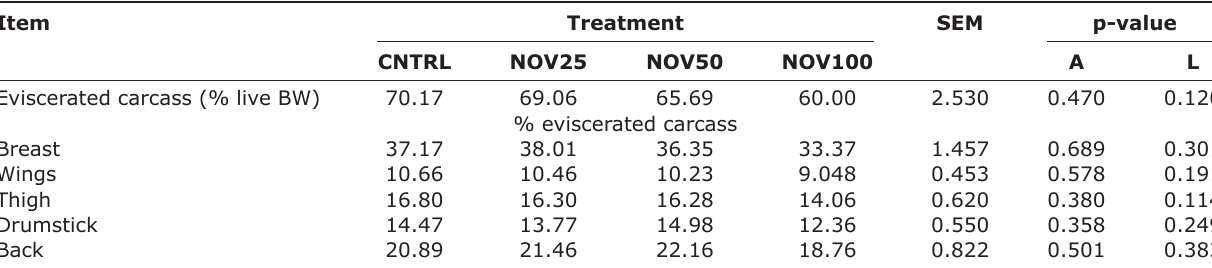
Table-4: Carcass and commercial proportions of broilers.